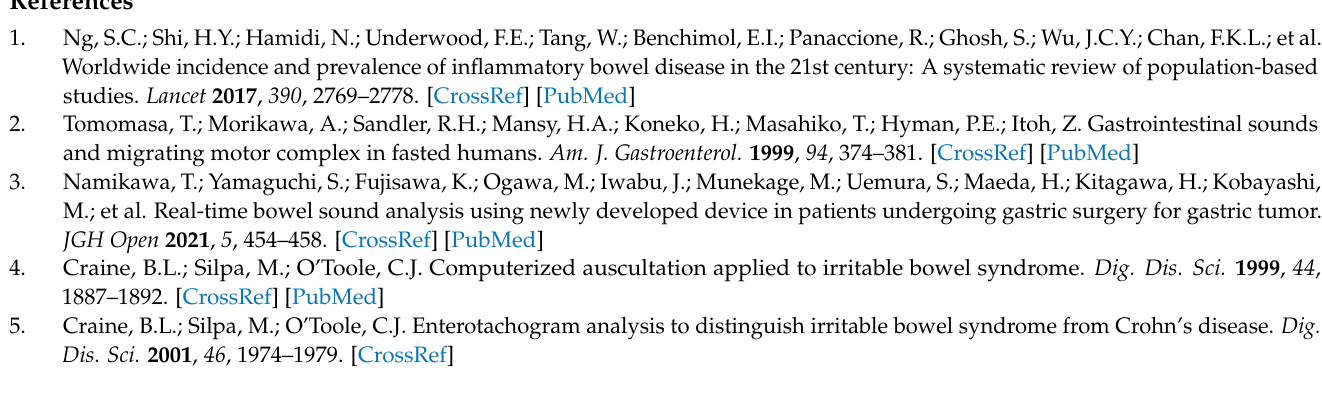
Table S3: Model performance between the recent similar work by Ficek et al. [9] and ours with the F